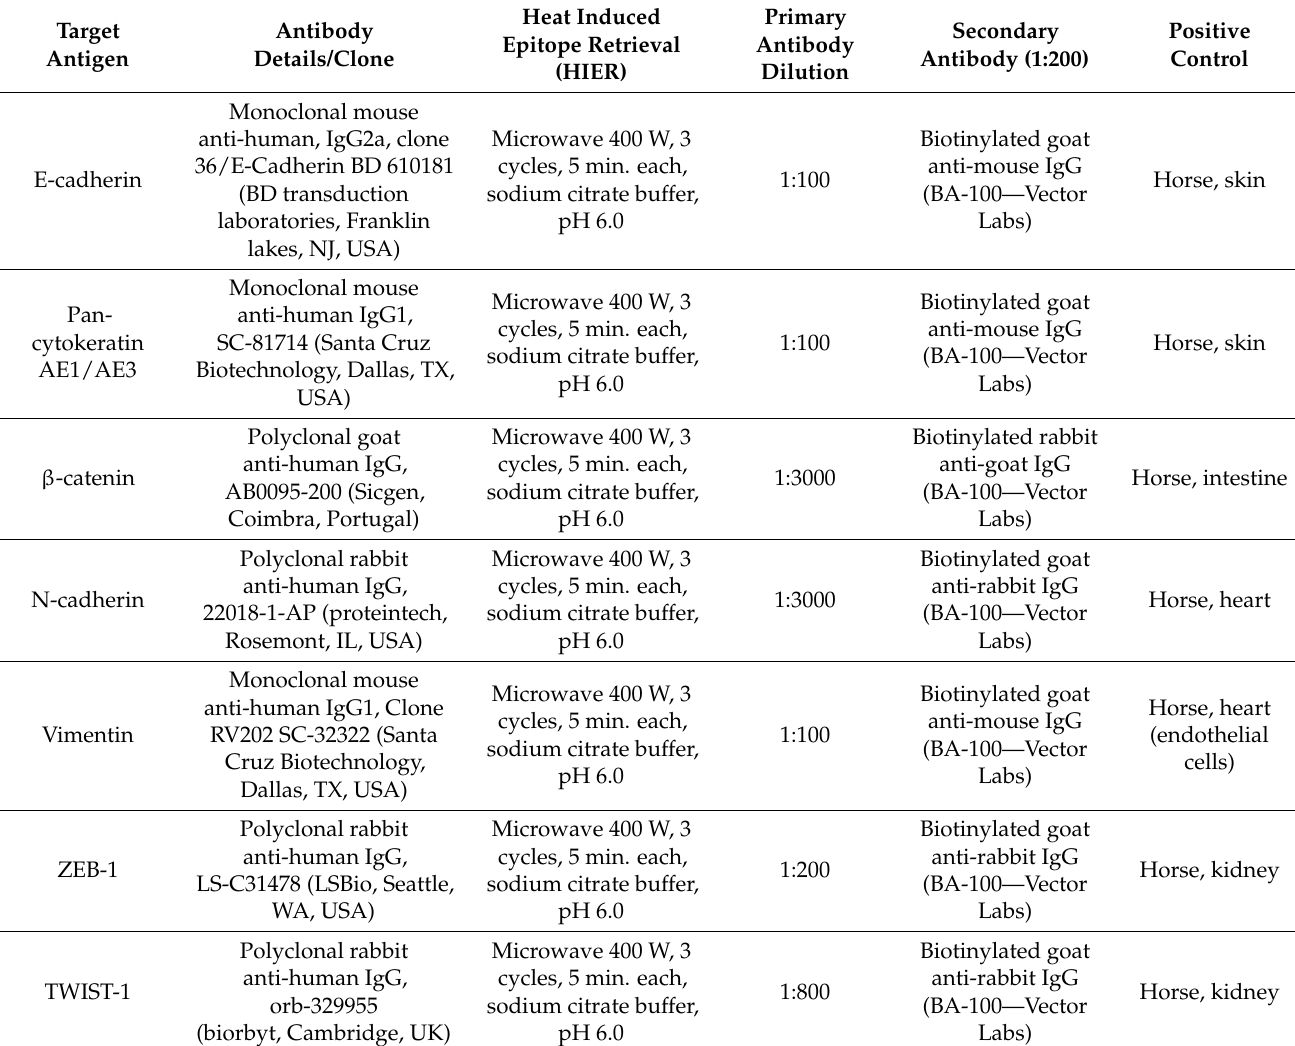
Table 2. Details of the antibodies used for immunolabelling, including primary antibody, host species, clonality, epitope retrieval method, dilution of primary antibody, secondary antibody, and positive